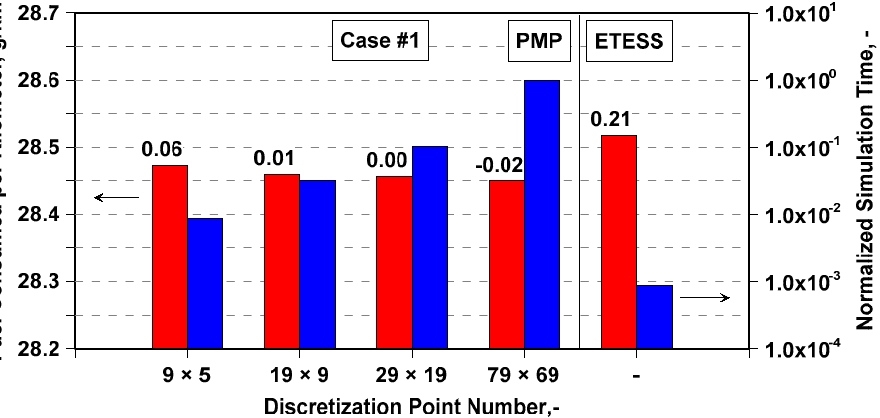
Figure 14. Assessment of kilometric consumed fuel and normalized simulation time in case #1 of Table 3, between off-line PMP, for different map grid discretization, and ETESS.